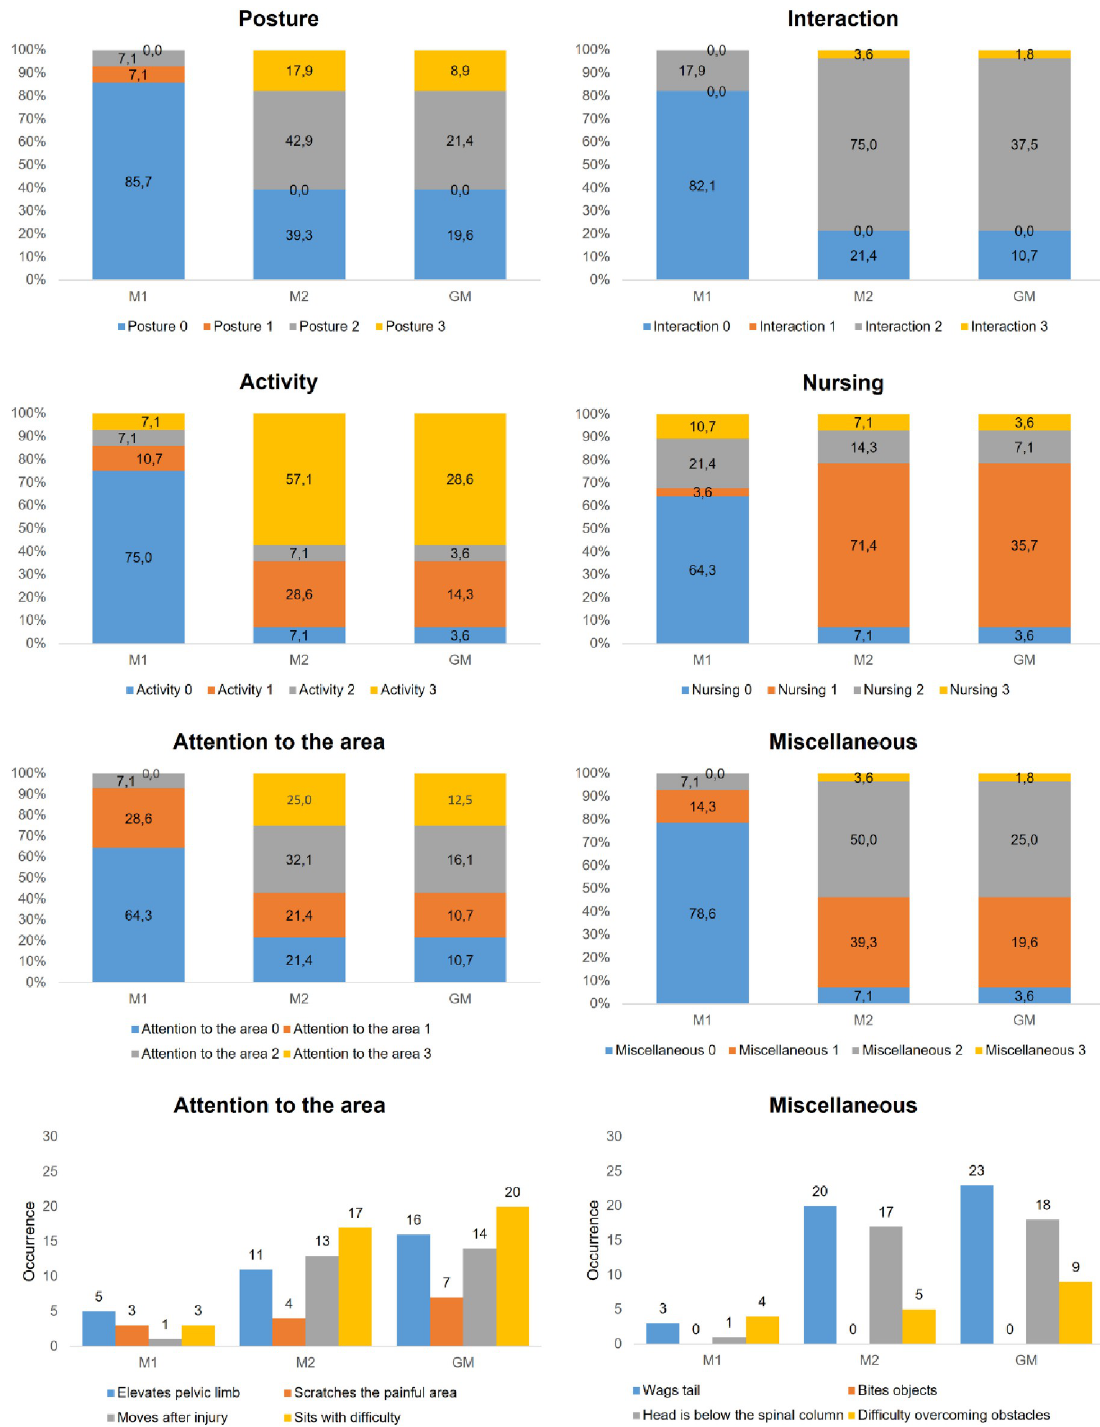
Fig 4. Distribution of UPAPS items scores (percentage of occurrence) in awake castrated piglets (n = 14). Legend: M1 (24h pre- procedure), M2 (15-min post-procedure, before rescue analgesia); GM—data of the grouped moments (M1 + M2).